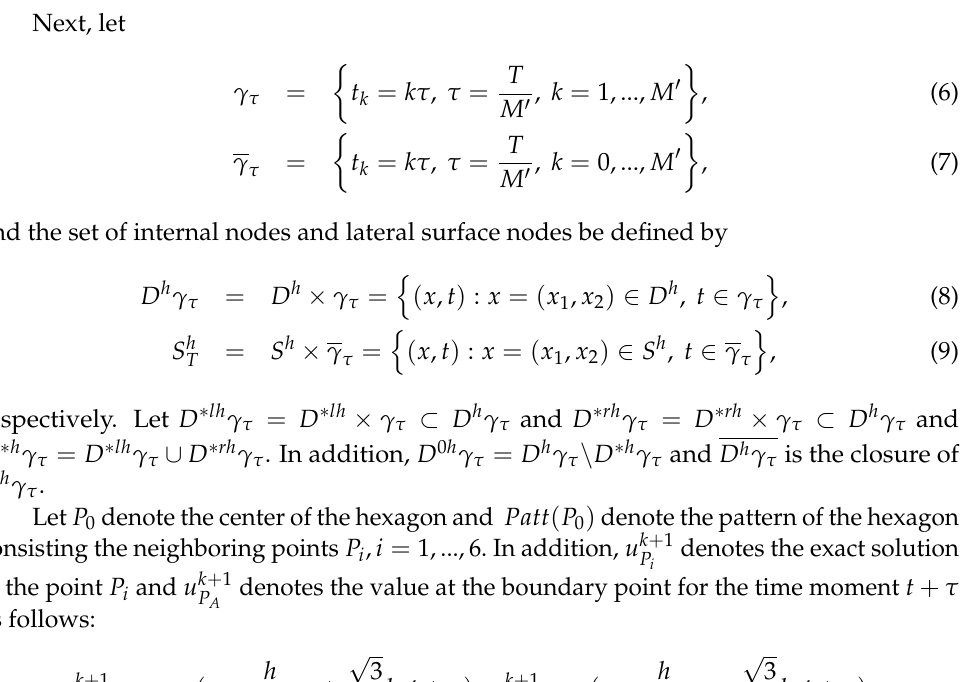
on the right ghost points at time moments t = k τ and ( k + 1 ) τ ,